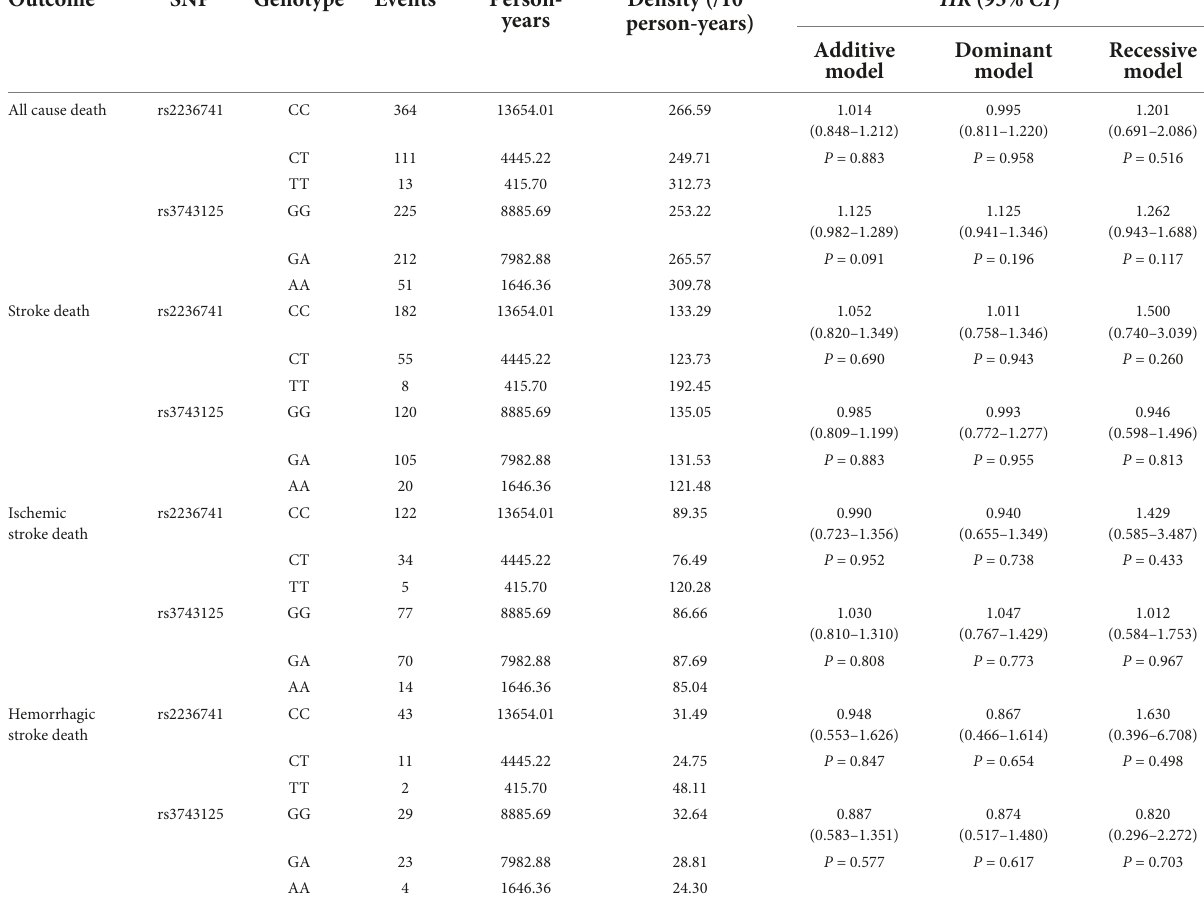
TABLE 5 Association analyses of THBS1 variants with the risk of long-term death after stroke*. Outcome SNP Genotype Events Person-